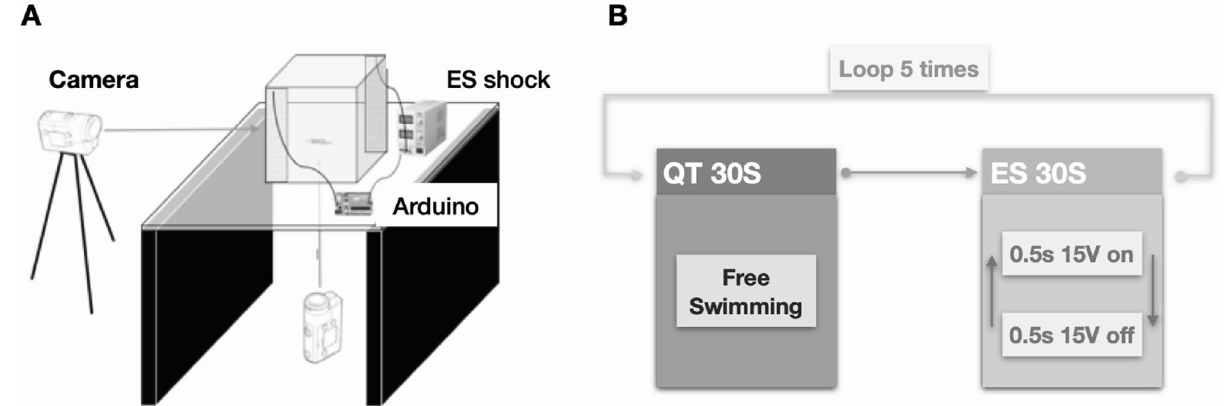
Figure 2. Schematics of the setup to acquire 3D trajectories in response to the experimental stimuli. ( A ) Experimental devices include an Arduino (open- source microcontroller)-based programmed electric stimulus system and a two-camera video capture system. Naive wild-type zebrafish were placed in an unfamiliar novel tank. Animal behavior was manually observed, and two cameras recorded videos for automated analysis in EthoVision XT10. Tracking data for each subject were exported, processed and visualized by customized MATLAB and R software programs. ( B ) Flowchart illustrating the electric stimulus treatment protocol: QT phase: 30 s of quiescent time for free swimming and ES phase: electric stimulus (500 ms on and 500 ms off) was delivered to the